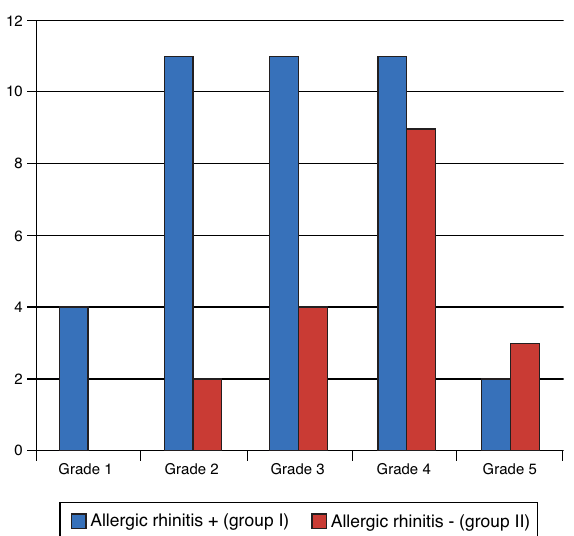
Figure 9 Degree of breathing improvement --- 90th day post- operatively.